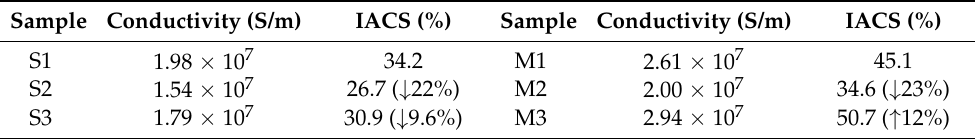
Figure 5. Electrical resistivity values retrieved from for Al-based nanocomposites reinforced with SWCNTs and MWCNTs. All values are compared with the standardized electrical resistivity value of pure aluminum (dashed blue line). Table 4. Electrical conductivity values, calculated from the electrical resistivity, and their correspond- ing conversion to the International Annealed Copper Standard (IACS%) values of spark plasma sintered Al-based CNT